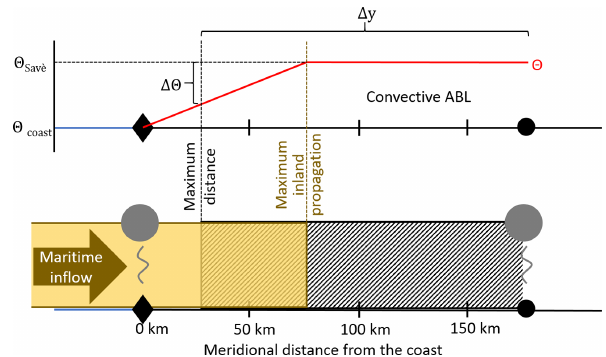
Figure 4. Schematic drawing illustrating the assumptions made for the estimation of horizontal advection using the example of a max- imum inland propagation of the marine inflow of 75km in the af- ternoon. In the bottom half, the different air masses are indicated: the cool maritime inflow (yellow area) is propagating inland from the south. The vertical dashed yellow line indicates the maximum inland propagation in the late afternoon. The propagation speed and the onset time of LLCs determine the maximum distance from which the air mass reaching Savè before the LLC onset may origi- nate (hashed area). Radiosoundings are performed at the coast (dia- mond) and at Savè (circle). In the upper half of the figure, the merid- ional potential temperature distribution, (cid:50) , is displayed. In the mar- itime inflow, the temperature increases linearly northwards from the coast, while it is constant in the continental ABL. For the estimation of horizontal advection, (cid:49)(cid:50) and (cid:49)y are